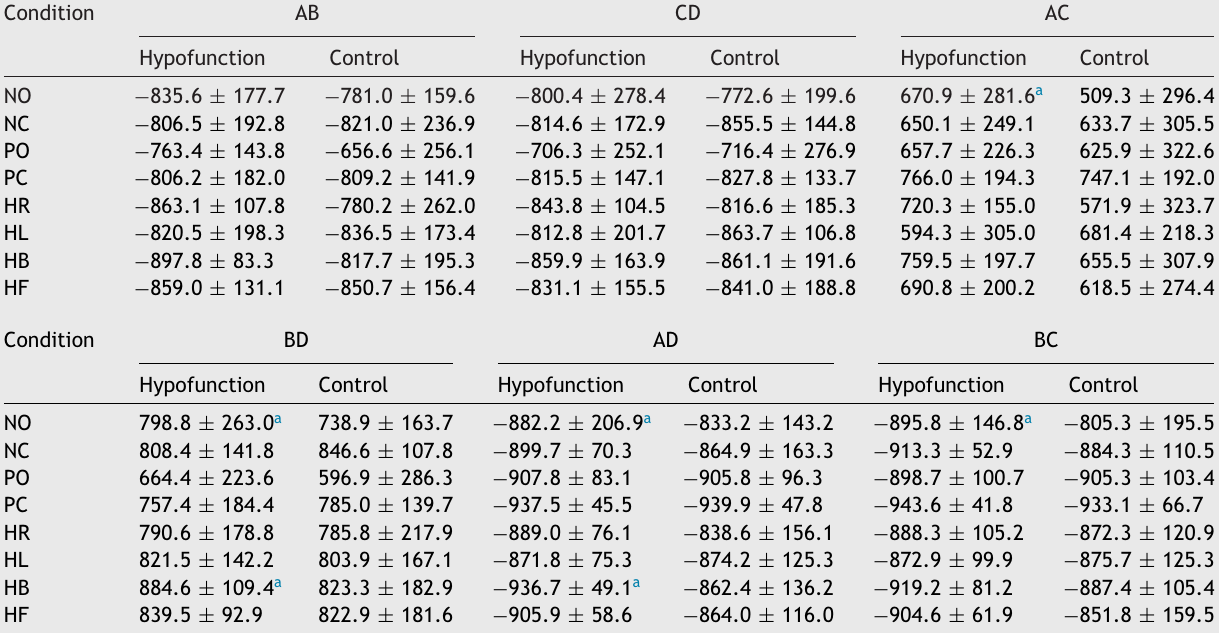
Comparative analysis of indices of synchronization in the eight conditions of the Tetrax Interactive Balance System (Tetrax TM ) in 32 control subjects and 25 patients with vertigo and unilateral vestibular hypofunction from the experimental